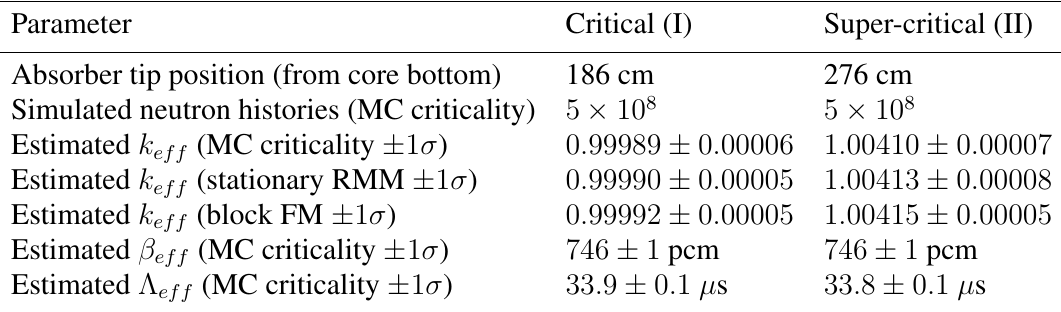
Table 1: Specifications of the investigated mini-core states.